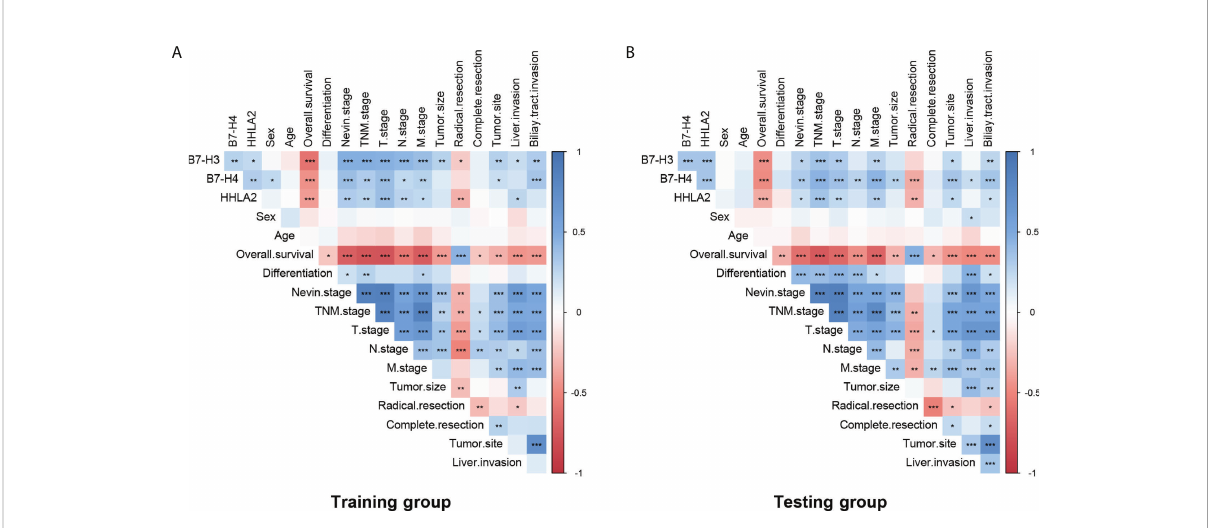
FIGURE 2 Potential correlation between B7-H3, B7-H4, HHLA2, and clinicopathological factors in patients with GBC. There were signi fi cant interrelationships between B7-H3, B7-H4, and HHLA2 in both the (A) training group and the (B) testing group. Different expression levels (high/ low) of B7-H3, B7-H4, and HHLA2 were signi fi cantly associated with pathological stages, clinical and surgical parameters, and prognostic survival. (*p < 0.05, **p ≤ 0.01, ***p ≤ 0.001; blank, no signi fi